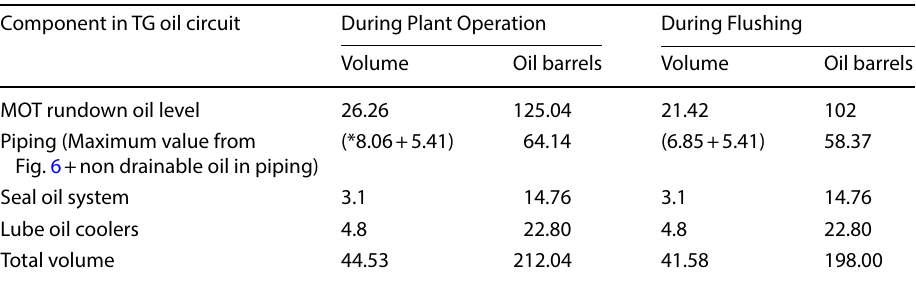
Table 2 Oil requirement during plant normal operation and